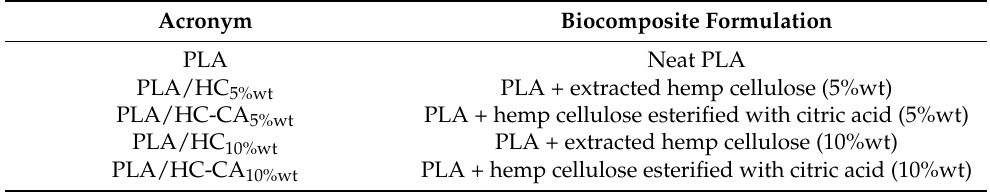
Table 1. Biocomposite formulations used in this